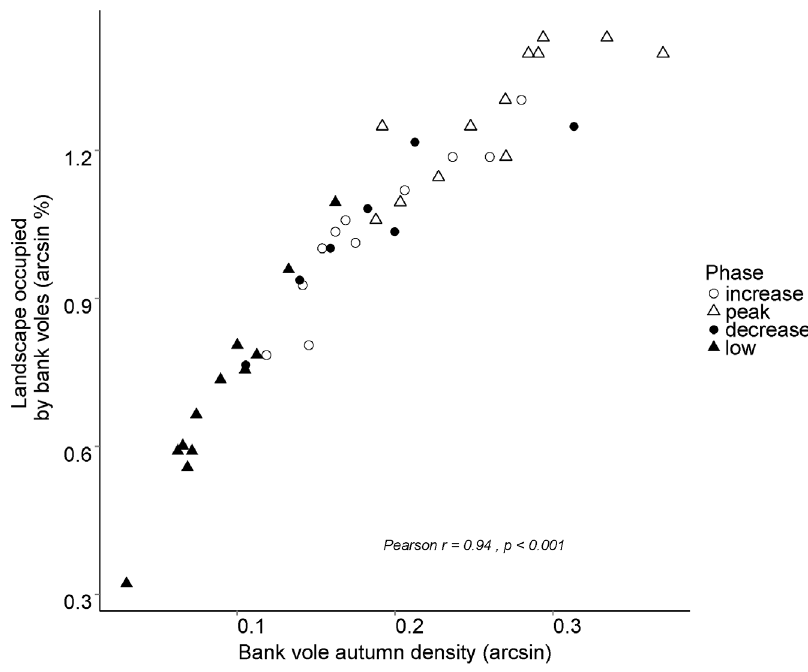
Figure 2. The relationship between proportion of occupied 1-ha plots (arcsine-transformed) (total number =58) and autumn bank vole density (number of trapped individuals per 100 trap nights) (arcsine-transformed) in 1971–2012 during the four phases of the vole cycle.